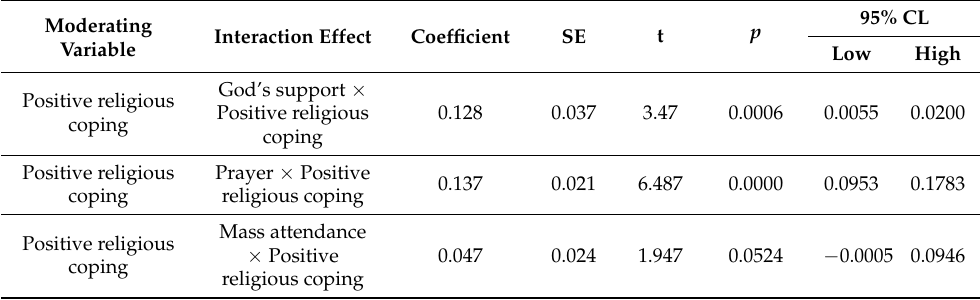
Table 3. Results of moderation analyses for life satisfaction as an outcome (dependent)